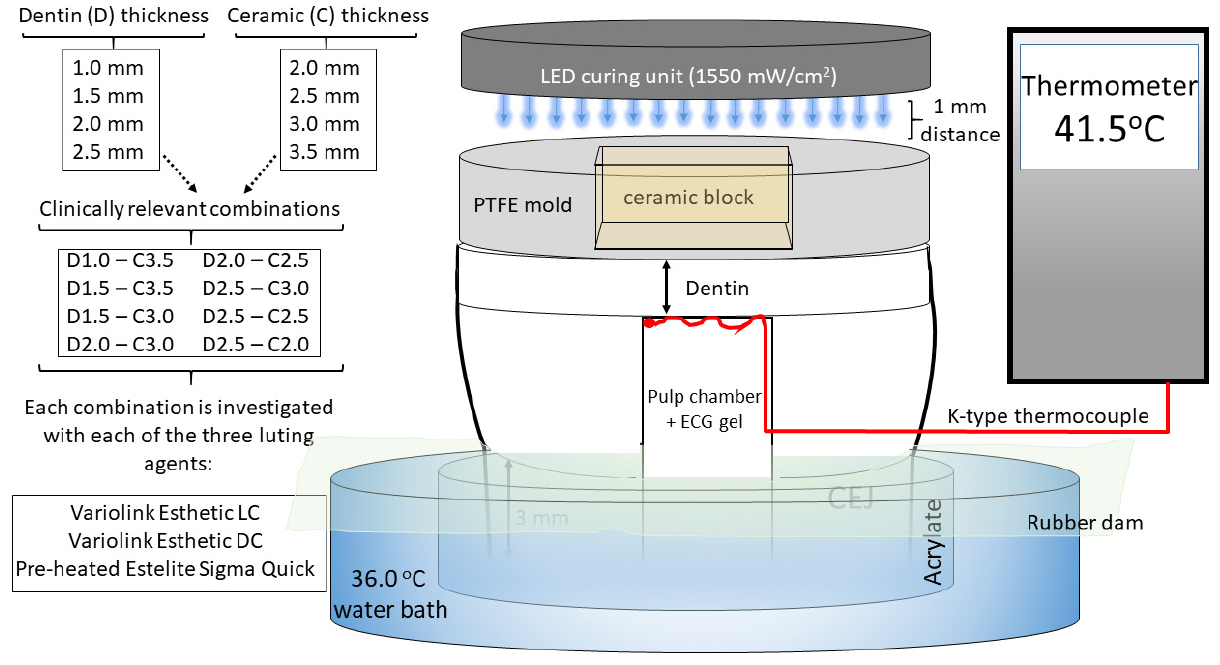
Figure 8. Schematic of the experimental set-up for pulpal temperature measurements. A standard volume of the luting agent was applied to the center of the non-glazed